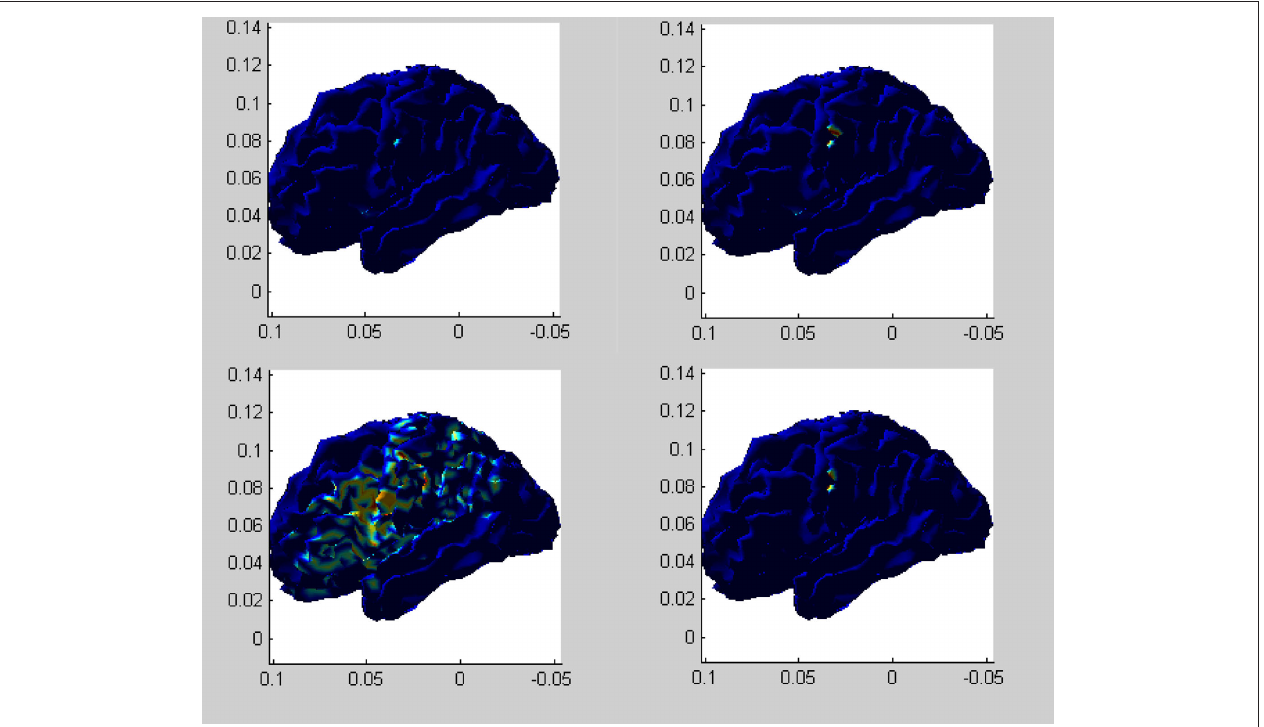
Figure 3 | reconstructed source maps at time point 85 (the side view). Upper left panel: FUNER (NCS); upper right panel: FUNER (SVD); lower left panel: MNE; lower right panel: